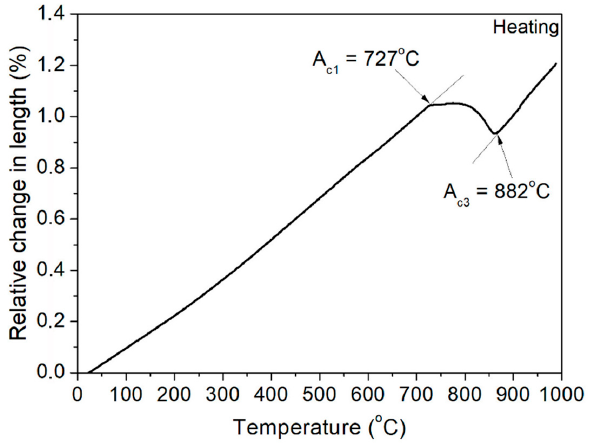
Figure 3. Dilatometric analysis of A c1 and A c3 temperatures.